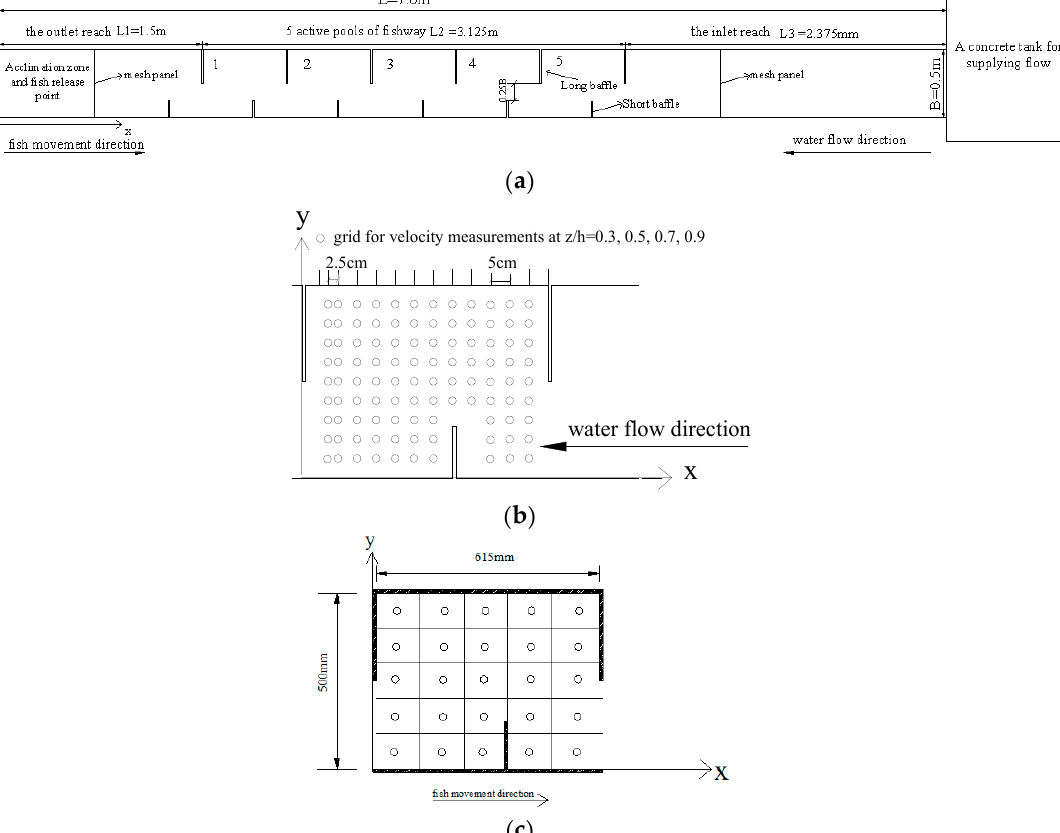
Figure 1. ( a ) The planform of the first experimental vertical-slot fishway (VSF); ( b ) the measured points in each horizontal plane in one pool of the first experimental VSF; ( c ) reference grid that was used for observing the fish behavior in one pool.